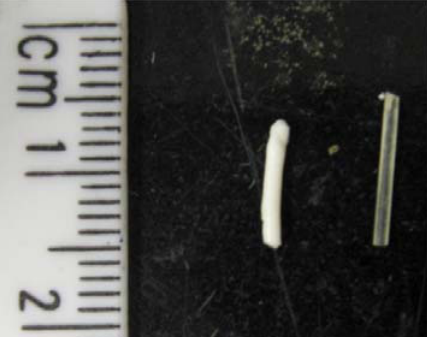
Figure 4. Photograph of the explanted cylinders at week 25. The TMC:DLLA cylinder (left) was white and had changed dimension, while the TMC:CL cylinder (right) had remained translucent and had not changed